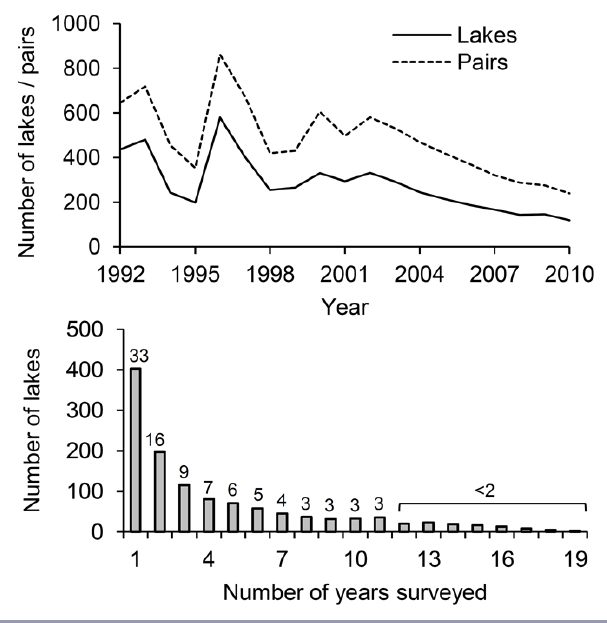
Fig. 2 . Number of lakes or pairs of Common Loons ( Gavia immer ) surveyed per year (upper panel) and the number of lakes as a function of the number of years surveyed (lower panel) by participants in Bird Studies Canada’s Canadian Lakes Loon Survey between 1992 and 2010. Numbers above bars show the value of each bar as a percent of the total number of lakes surveyed.